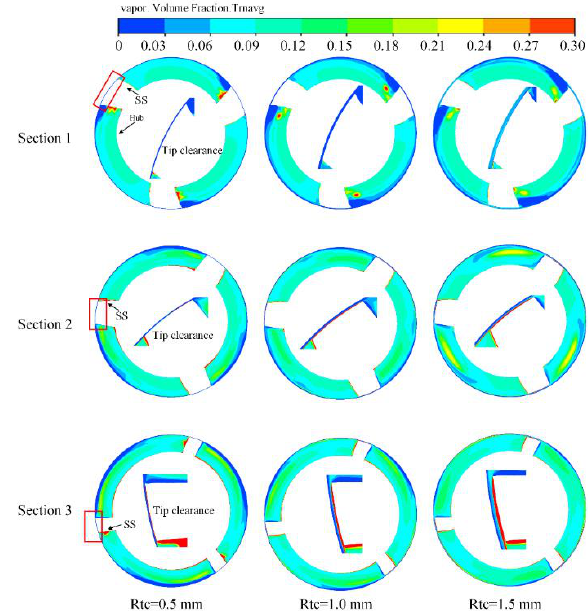
Figure 11. Gas distribution on different sections.